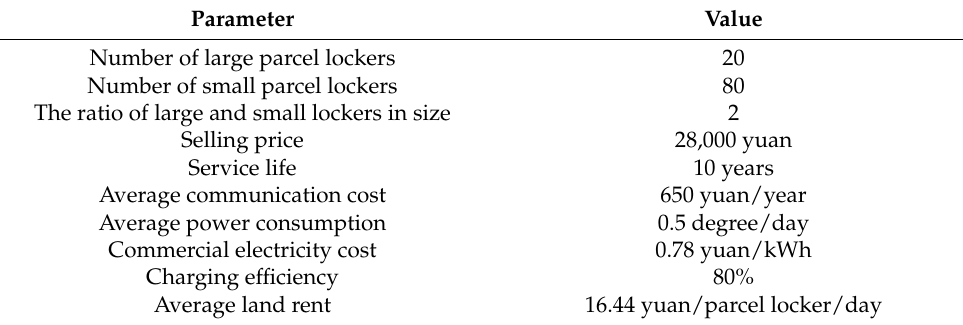
Table 2. Primary parameters of a unit of parcel